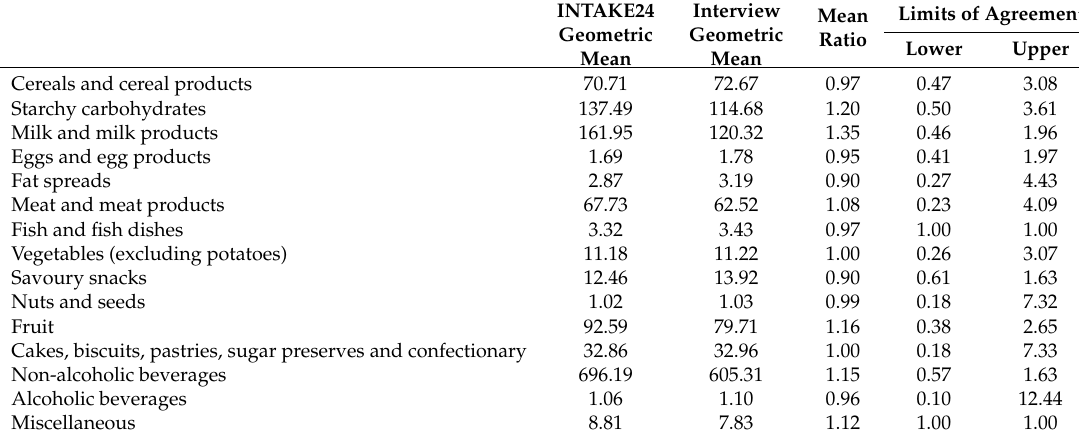
Table 4. Agreement of intakes of main food groups for 11–16 years old, ( n = 52).